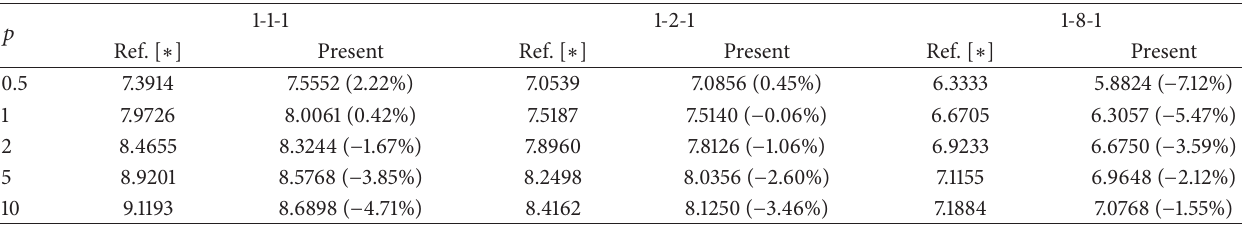
Table 2: Comparison of the nondimensional fundamental natural frequencies ( 𝑤 ) with various thickness ratios of the sandwich beam ( 𝐿/𝐻 = 5 ).